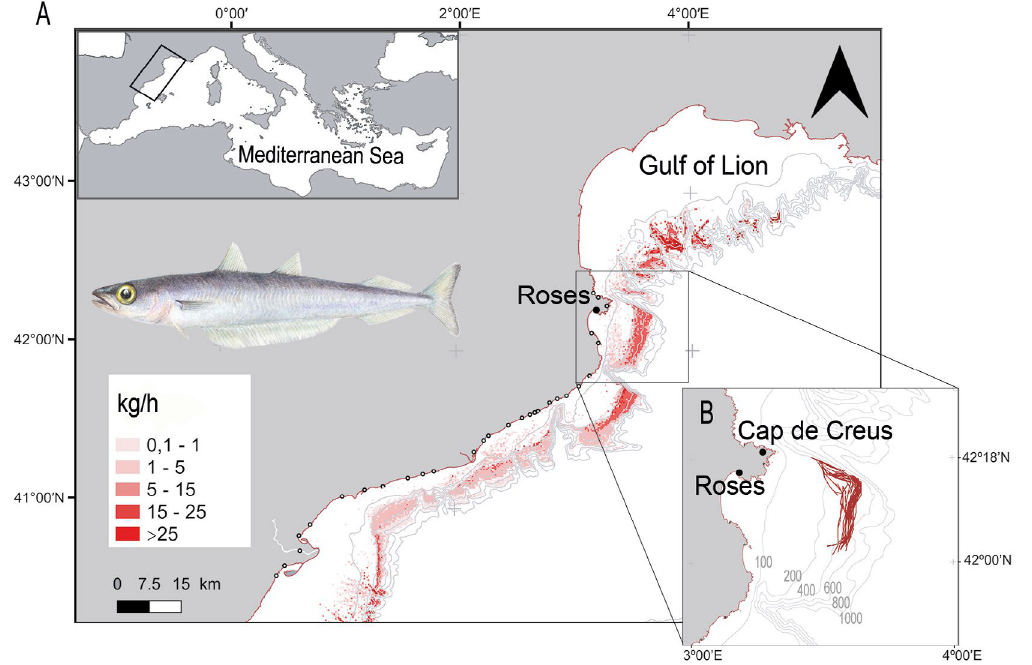
Fig. 1. − Study area. A, production map of blue whiting along the Catalan coast in 2017 defining the species fishing grounds, and B, sampling area off Roses showing the vessel fishing tracks over the shelf break and upper slope. Blue whiting illustration by